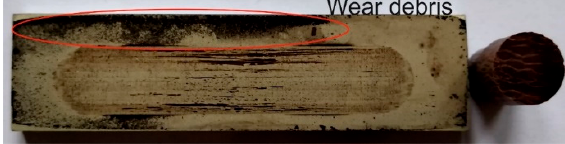
Figure 13. Photographs and SEM micrographs of Al 2 O 3 /IF-WS 2 tribological pairs after a tribological test with PF + cotton + C.